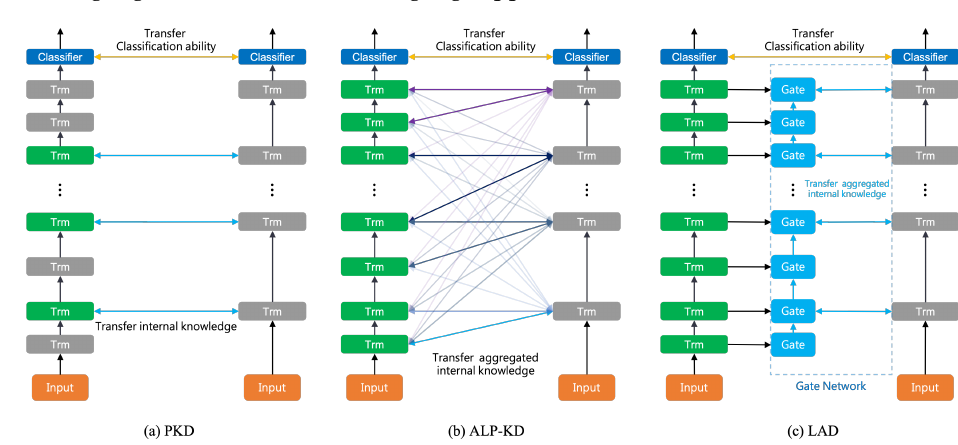
Figure 1. Differences in model structures of three distillation frameworks. Trm means a Transformer layer. In each subplot, the left shows the teacher model, and the right indicates the student model. ( a ) Patient knowledge distillation (PKD) [14]; ( b ) Attention-Based Layer Projection for Knowledge Distillation (ALP-KD) [15]; ( c ) Our proposed